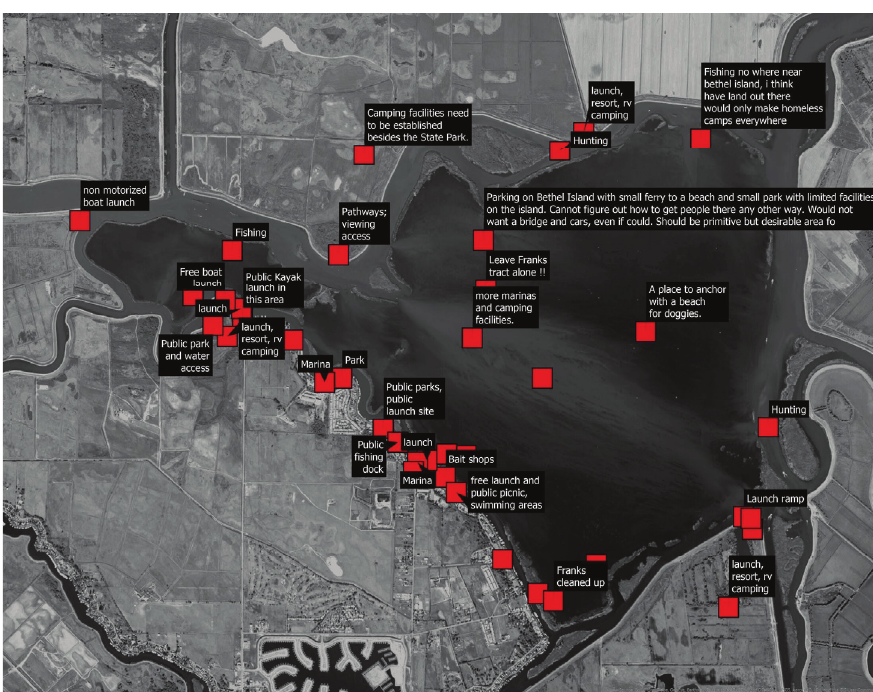
Figure 9. Where do you recreate and what activities do you do at this location? Results indicate the diversity of recreational uses and their use patterns across Franks Tract. Fishing appears to be most common along the vegetated remnant levees, which was validated in conversations with local anglers.